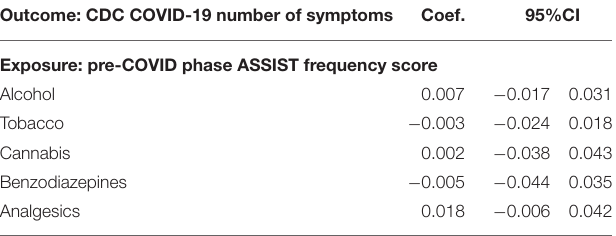
TABLE 1 | Results of the Poisson regression model for number of CDC COVID-19 symptoms among 993 individuals who had mild COVID-19 in São Caetano do Sul, SP,